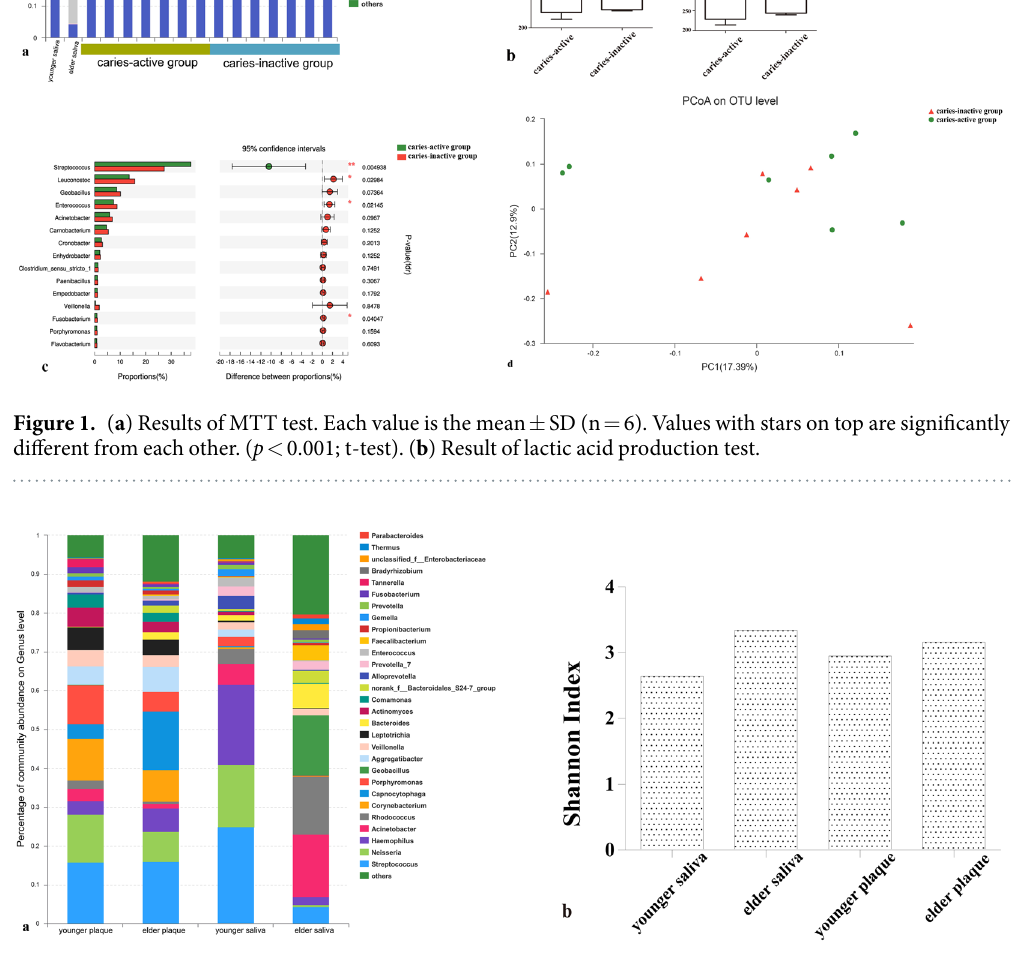
Figure 2. Composition and diversity of bacterial community in saliva and dental plaque samples of the twins. ( a ) Abundance of bacteria of the twins’ saliva and plaque samples at genus level. ( b ) Diversity of bacterial community from the host saliva and dental plaque